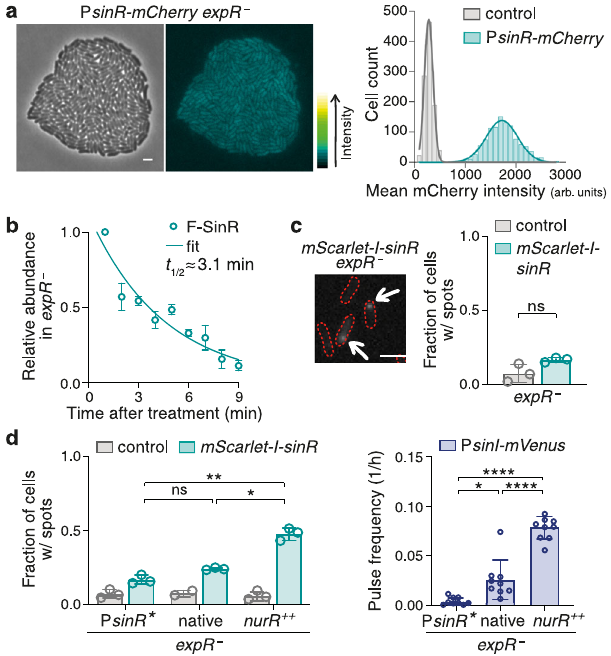
Fig. 2 SinR scarcity is a key factor in sinI expression pulsing. a (Left) Raw phase contrast and fl uorescence microscopy images of a strain carrying a sinR promoter- mCherry fusion, and the ‘ green fi re ’ lookup table applied to the fl uorescence image. Scale bar, 2 µ m. (Right) Frequency distributions of mean mCherry intensities per cell and corresponding Gaussian fi ts suggest homogeneous sinR expression in the expR − strain. Pooled data from snapshots of 7 and 6 colonies, respectively, imaged on 2 different days. N = 1077 (P sinR-mCherry) , 1004 (promoterless control). b Relative abundance of Flag-tagged SinR (F-SinR) after chloramphenicol treatment in 1-min intervals determined by Western blot analysis and a one-phase exponential decay fi t to the data. Data, means ±standard deviations of 3 biological replicates. c (Left) Cut-out from a single-molecule microscopy snapshot of an expR − strain expressing an mScarlet-I-sinR fusion from the chromosomal sinR promoter. Arrows mark fl uorescing spots. (Right) Bar plots indicating the fraction of cells with fl uorescing spots in this strain and the corresponding control strain lacking the fl uorophore gene in 3 biological replicates; bars represent means±standard deviations, open circles represent individual data. Statistical test, two-tailed unpaired t -test with Welch ’ s correction. ns, not signi fi cant; P = 0.1149. Total number of cells analysed: N = 2293 ( mScarlet-I-sinR ), 1670 (control). d Manipulation of ( mScarlet-I-) sinR transcription levels yields corresponding patterns of (left) the fraction of cells displaying mScarlet-I-SinR spots in single-molecule microscopy and (right) P sinI-mVenus expression pulse frequencies in time-lapse fl uorescence microscopy. P sinR *, promoter mutation resulting in reduced transcription; native, native promoter; nurR ++ , native promoter while overproducing its transcription activator NurR. Bar plots indicate means ± standard deviations and individual data from (turquois) single-molecule microscopy (SMM) performed in 3 biological replicates and (blue) time-lapse fl uorescence microscopy of 9 colonies imaged on 3 different days. Statistical tests, Welch ’ s ANOVA tests with post hoc Dunnett ’ s T3 multiple comparisons test. ns, not signi fi cant; *, P <0.05; **, P <0.01; ****, P <0.0001. Multiplicity-adjusted P values: P sinR * vs. native 0.1119, P sinR * vs. nurR ++ 0.0012, native vs nurR ++ 0.0217 for SMM data, 0.0290, <0.0001, <0.0001 for pulse data, respectively. Total number of cells analysed: N = 1260 (P sinR *), 1142 (native), 1158 ( nurR ++ ) for SMM data, 3411, 2900, 2440 for pulse data,